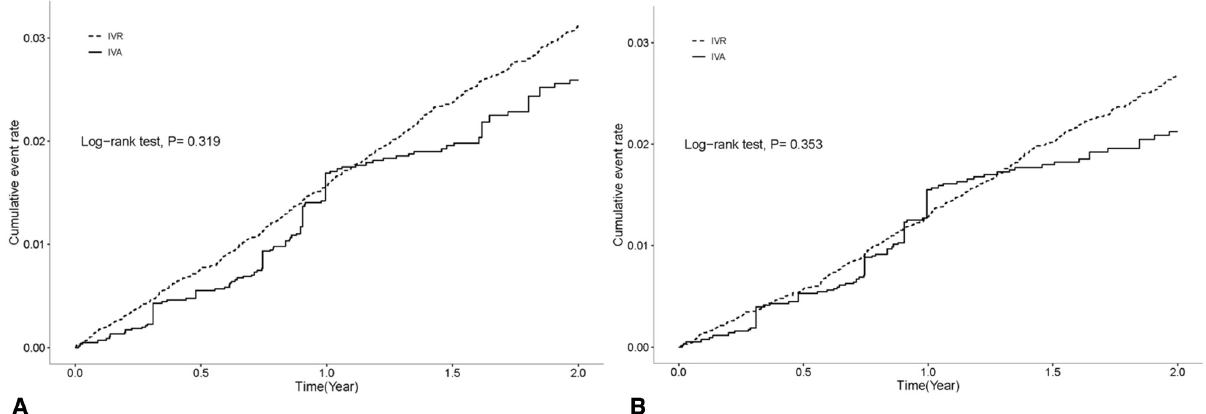
Fig 2. Kaplan–Meier Failure Curve of ATEs (IS and AMI Hospitalization) in patients receiving IVA injection compared with those receiving IVR injection: (A) Overall cohort (B) Cohort without a history of AMI or IS. AMI = acute myocardial infarction; ATE = arterial thromboembolic event; IS = ischemic stroke; IVA = intravitreal aflibercept; IVR = intravitreal ranibizumab.